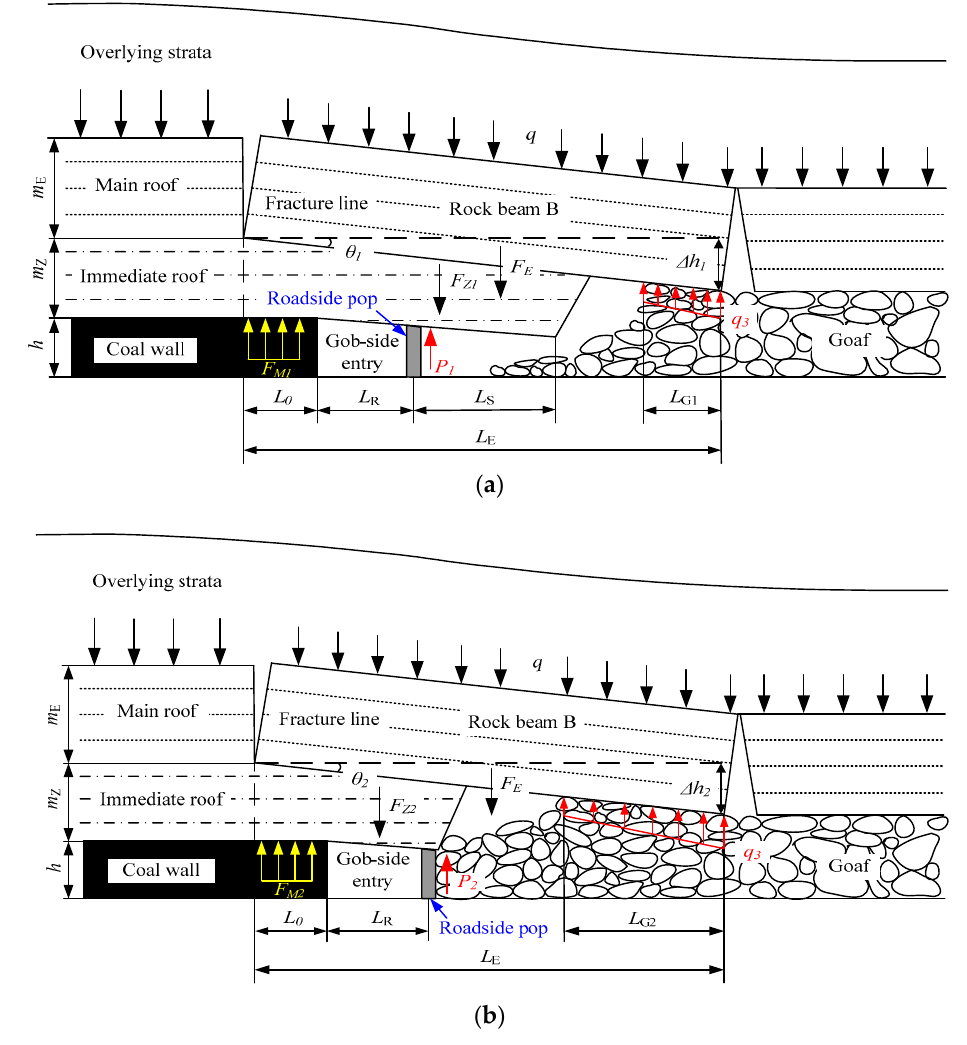
Figure 5. Mechanical model for GER (gob-side entry retaining). ( a ) Non-roof-cutting; ( b ) Roof-cutting.